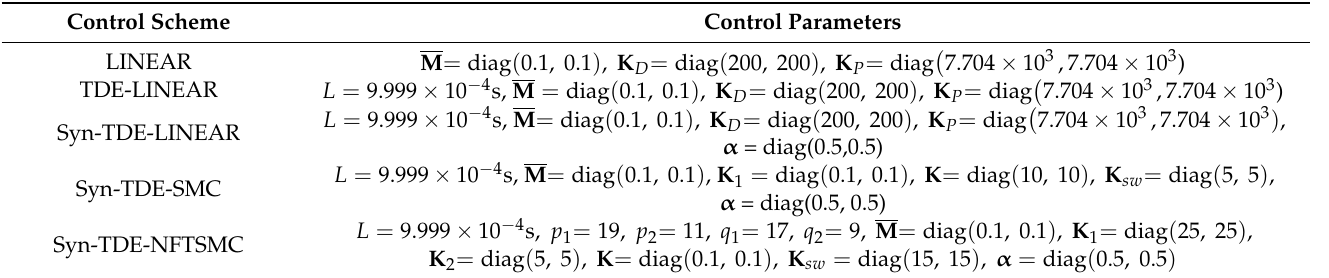
Table 2. The parameters of the control